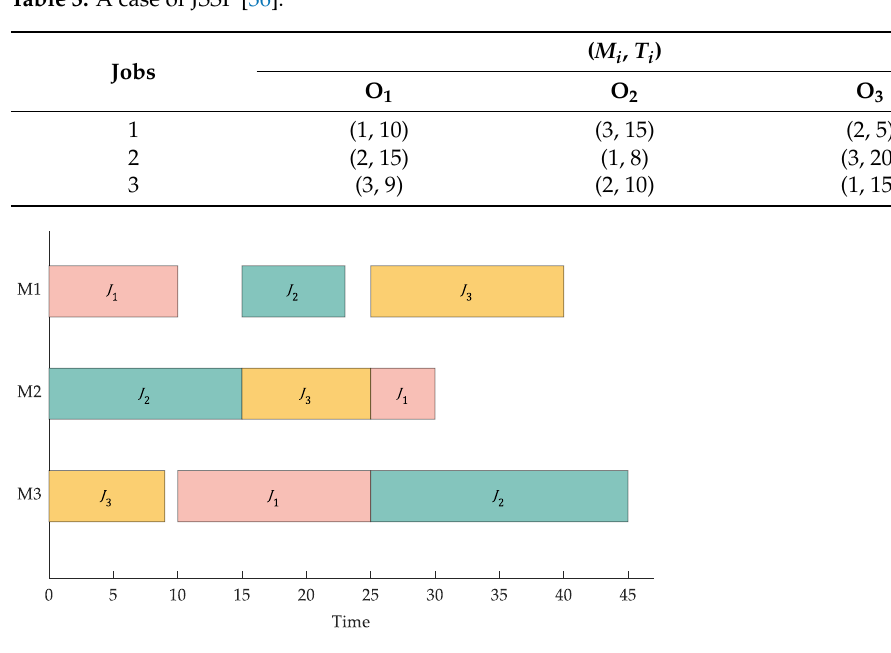
Figure 2. SOI-based decoding mapping.